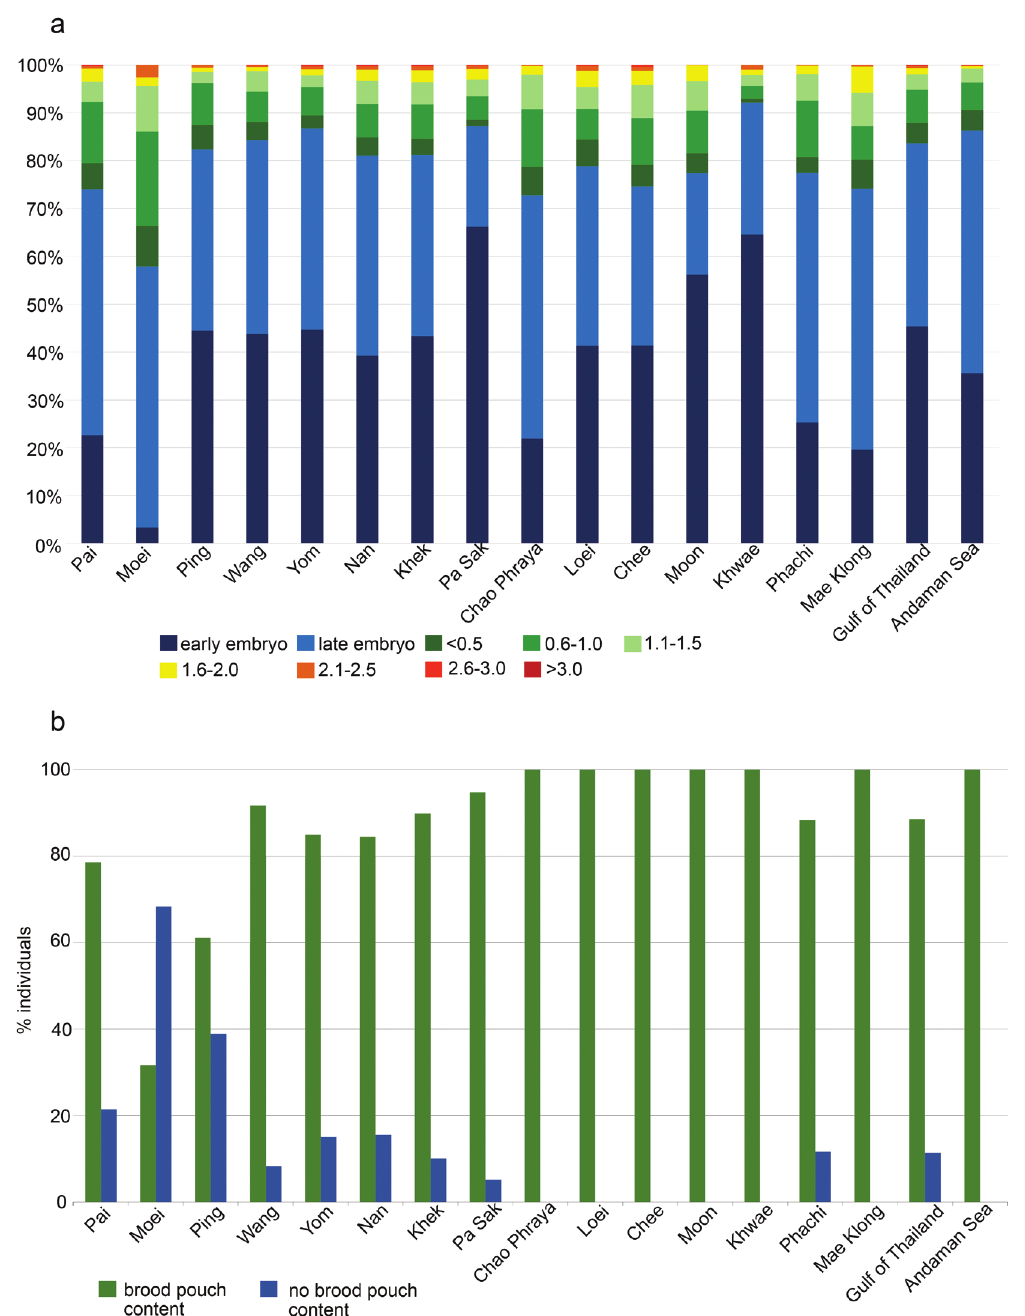
Figure 11. Composition of contents of the subhemocoelic brood pouches of female Tarebia granifera (Lamarck, 1816) ( a ) and proportions of gravid animals, i.e. those with brood pouch containing juveniles or other stages, and non-gravid specimens ( b ) from Thailand grouped according to rivers. For colour coding, see the inset